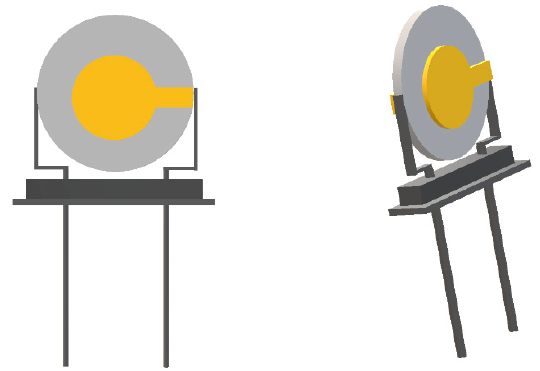
Figure 4. Schematic representation of a QCM sensor chip.